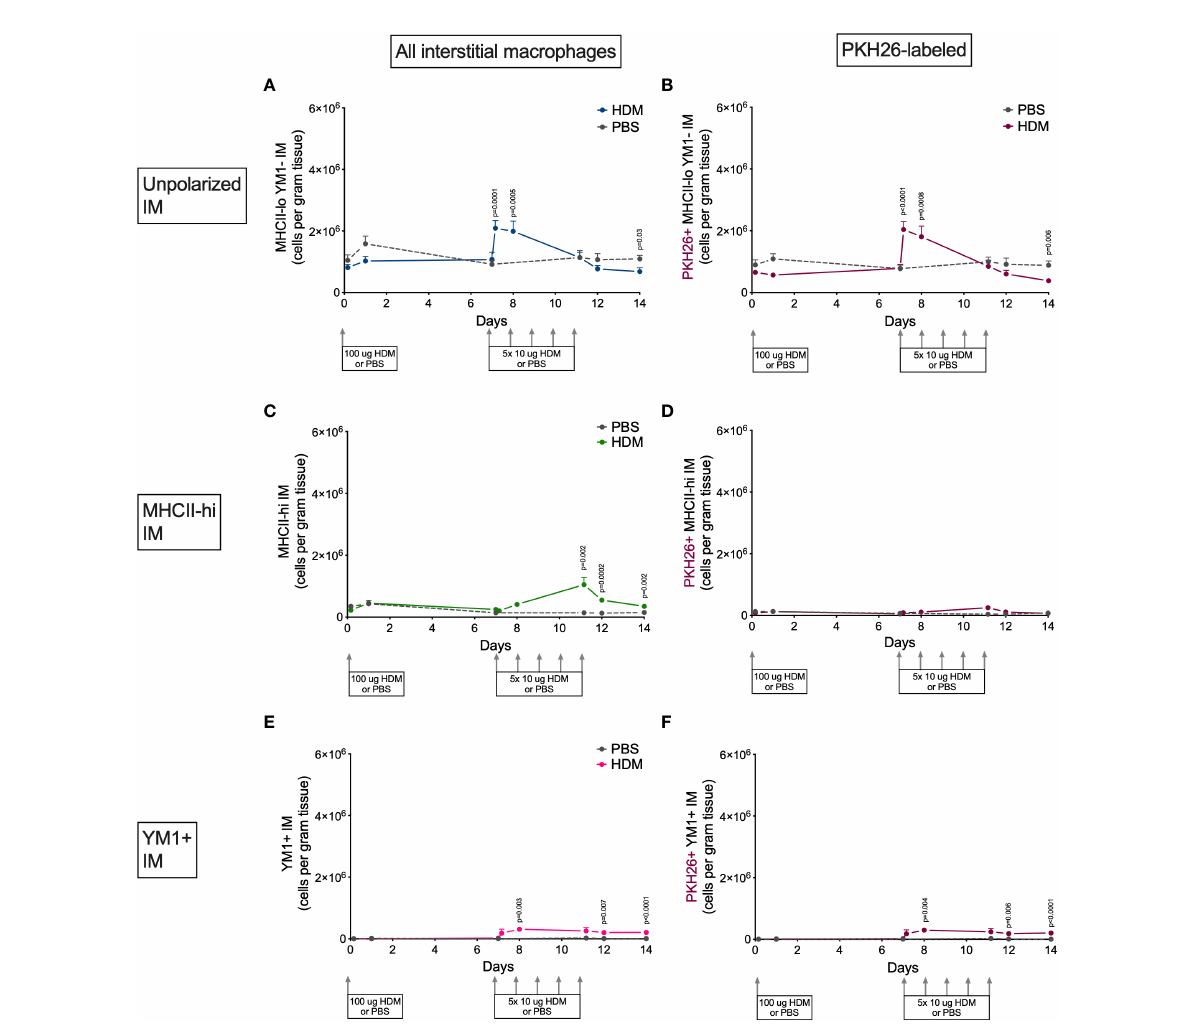
FIGURE 7 Numbers of (A) MHCII-loYM1- interstitial macrophages, (B) PKH26+MHCII-loYM1- interstitial macrophages, (C) MHCII-hi interstitial macrophages, (D) PKH26+MHCII-hi interstitial macrophages, (E) YM1+ interstitial macrophages, (F) and PKH26+YM1+ interstitial macrophages in lung tissue of house dust mite (HDM)-exposed and phosphate-buffered saline (PBS)-exposed mice at different time points during exposure. The differences between HDM and PBS per time point were tested using a Student ’ s t test. Day 7.2 and day 8 of HDM were compared to day 7 of PBS with a one-way NoANOVA with Sidak ’ s correction for multiple testing because these mice did not have matching PBS-exposed